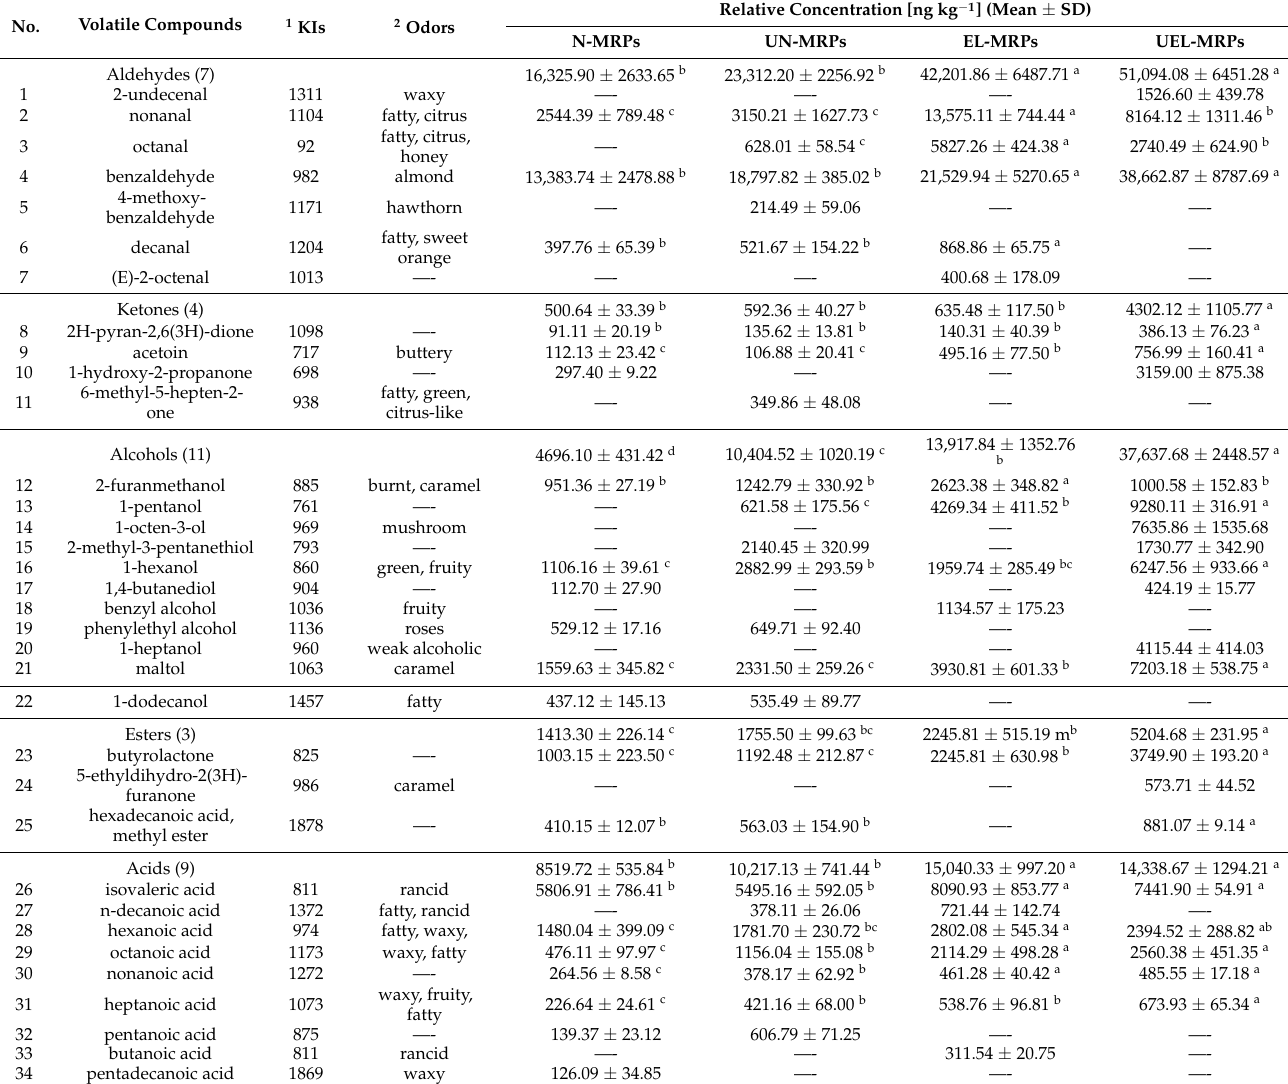
Table 3. Volatile compounds in the